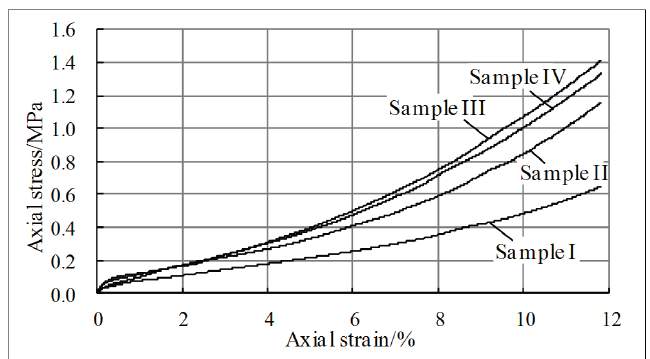
Figure 5. Curves of the axial stress and strain of the tailing